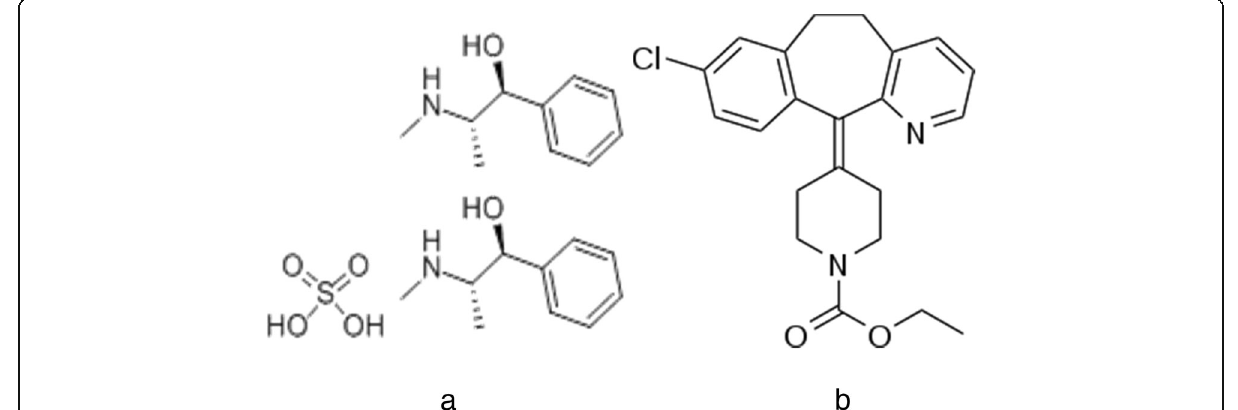
Fig. 1 Structural formulae for a pseudoephedrine sulphate and b